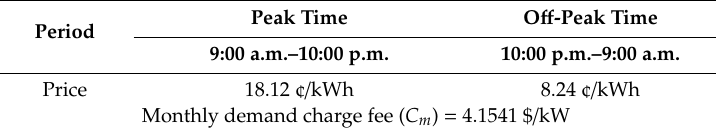
Table 2. Electricity tariff data from [34].